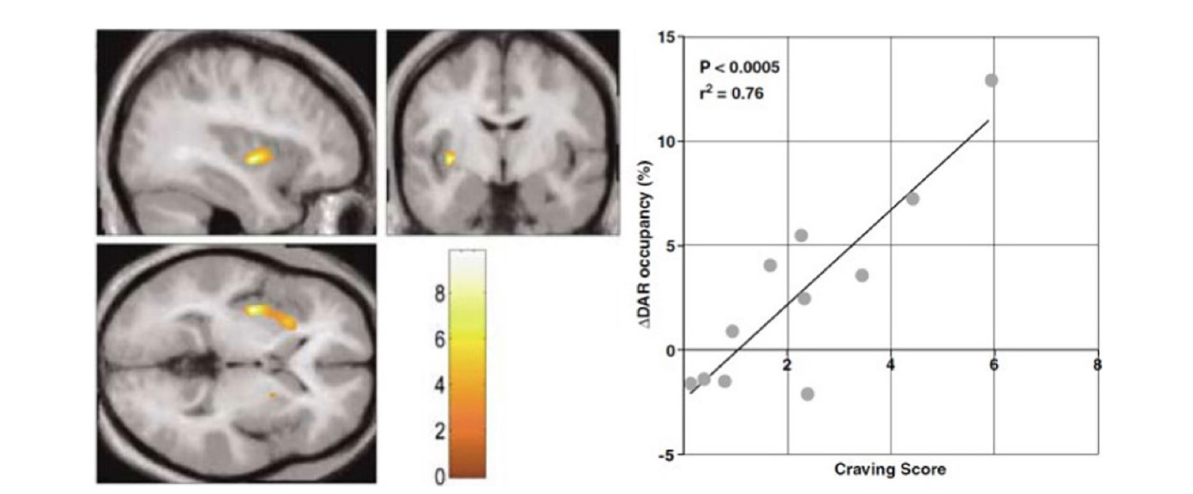
FIGURE2 Endogenous release of intrasynaptic dopamine. PET study of [ 11 C]raclopride binding during audiovisual cocaine craving cues. Abstinent cocaine abusing subjects received two consecutive PET imaging sessions, one with neutral cue during baseline PET, and one with the craving cue during second PET session. Statistical Parametric Mapping (SPM) showed clusters of volumes of interest with significantly increased dopamine release assumed to explain the changes of endogenous neurotransmitter occupancy of dopamine D 2 /D 3 receptors in striatum. Left panel: SPM clusters in left anterior putamen where increased release of endogenous dopamine is alleged to raise dopamine receptor occupancy in response to craving cues with increased craving scores. Right panel: Scatterplot and regression of percent change of dopamine receptor (DAR) occupancy correlated with craving score for the cluster (adapted from Wong et al., 2006). Color scale shows correlation with craving